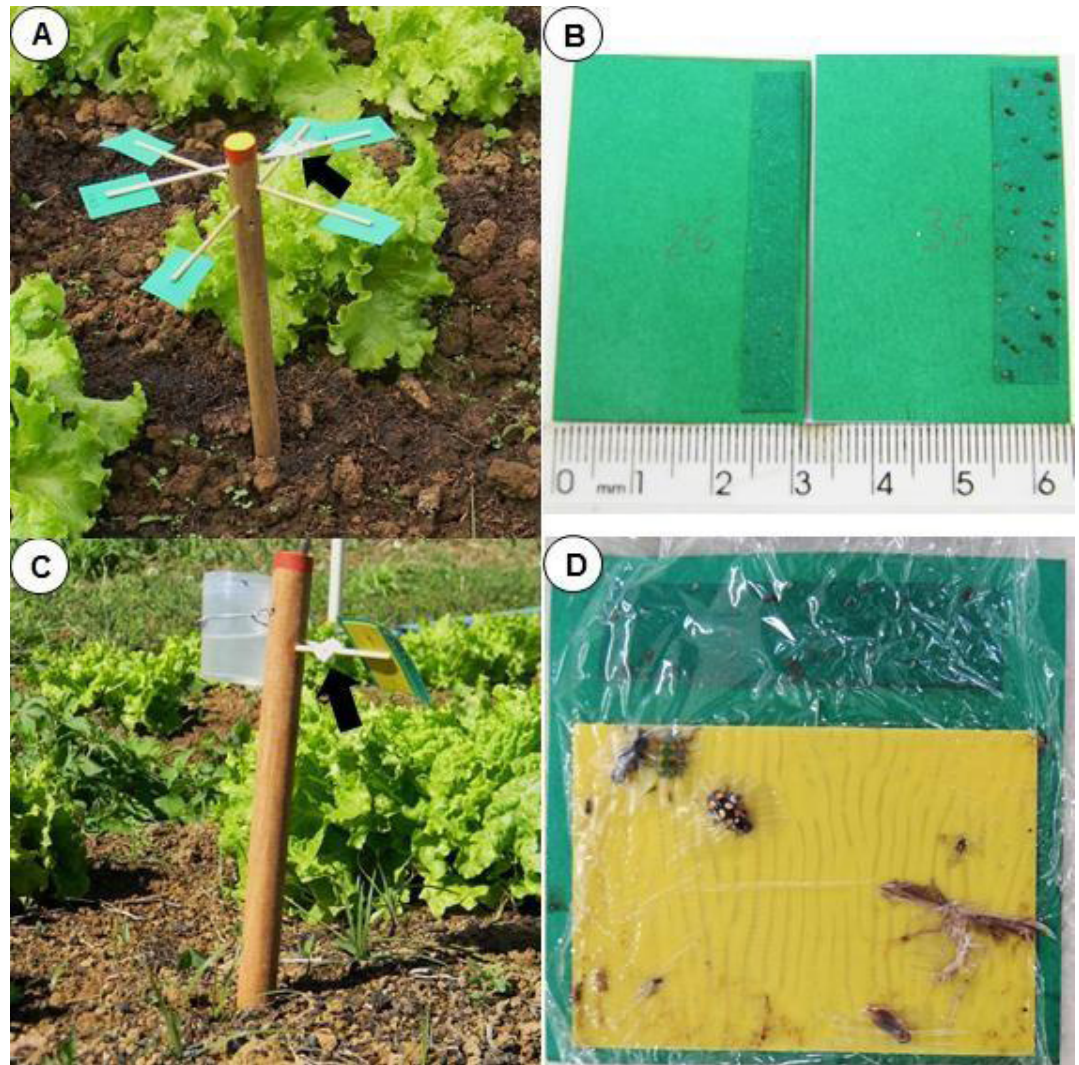
Fig 2. Images of the methodology used in the 18 locations of organic vegetable production in the Rashad, Sudan, from February to June 2020 and February to May 2021. (A) Photograph of one of the 720-predation stakes in the field, where two cards with eggs of Belenois solilucis were available. (B) Photo of the egg cartons after 24 hours in the field, with the number of initial eggs written in pencil, and the predation of all eggs on the left cartouche occurred. (C) Photograph of one of the 320 sampling stakes, containing a universal collector and a yellow adhesive trap card. (D) Photo of one of the sampling cards that remained in the field, with a strip containing eggs as an attractant on top and covered by transparent plastic for storage. Arrows indicate the locations in (A) and (C) that have white grease preventing ants’